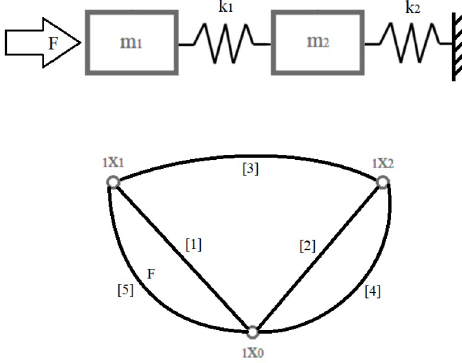
Figure 8. A full graph representation of the cascade